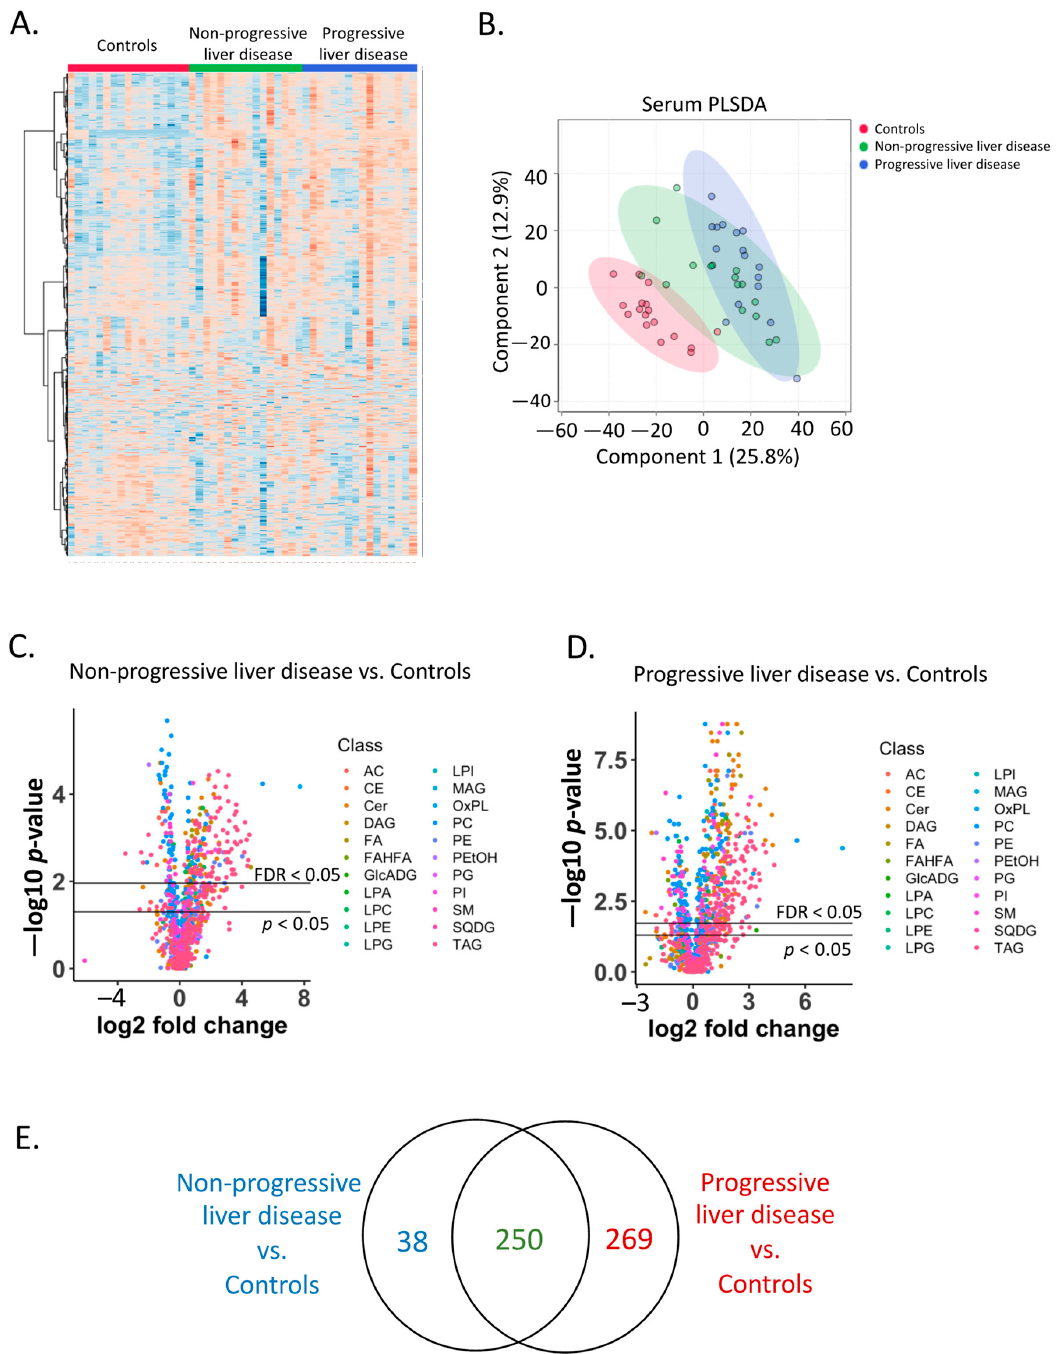
Figure 1. Serum lipidome. ( A ) Heatmap of the serum lipidome in the control and two patient groups. ( B ) Partial least squares-discriminant analysis of the serum lipidome. ( C ) Volcano plot of the serum lipidome in control subjects and patients with non-progressive liver disease. Different colors represent different lipid classes. Fold change: non-progressive liver disease ( n = 16)/controls ( n = 17). ( D ) Volcano plot of the serum lipidome in control subjects and patients with progressive liver disease. Different colors represent different lipid classes. Fold change: progressive liver disease ( n = 16)/controls ( n = 17). ( E ) Venn diagram of significant serum lipids (adjusted p -value < 0.05). Dark blue: number of unique significant lipids between non-progressive liver disease and controls; Red: number of unique significant lipids between progressive liver disease and controls; Dark green: shared significant lipids.